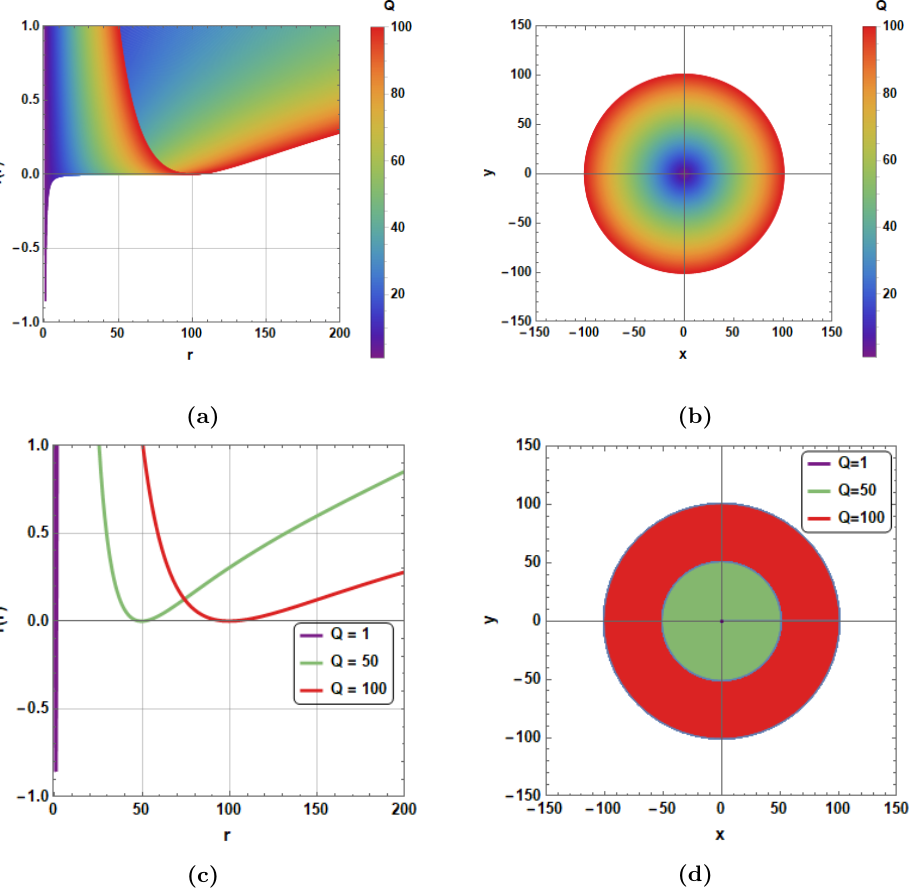
Figure 26. (a) and (c): evolution of f ( r ) function during absorption of 10 5 particles with a fixed electric charge dQ = 0 . 001 . (b) and (d): evolution of black hole projection on xy plan during absorption of 10 5 particles with a fixed electric charge dQ = 0 . 001 . The initial conditions are Q 0 = 1 , l = 1 , M 0 = 1 . 5 , r h = 1 and D = 4